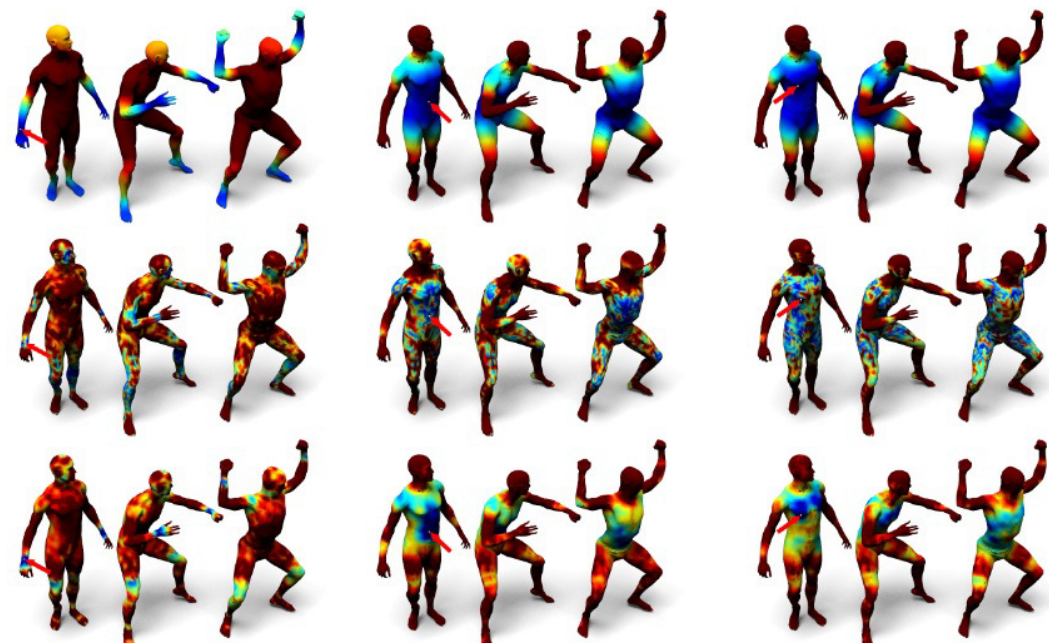
Figure 11. Three kernel-based distance visualized on human models. Visualized distances between the reference point (pointed with red arrows in the first column of each sub-group) and other points on the model. On the left, the reference point is the right writs, in the middle the belly, and on the right the chest. The first row shows the results from the heat kernel, the second row shows the results form the wave kernel, and the third row shows the results of the proposed kernel in [95]. Dark blue shows small distances; red represents large distances. ©2014 IEEE. Reprinted, with permission, from R. Litman, and A. M. Bronstein, Learning Spectral Descriptors for Deformable Shape Correspondence, in IEEE Trans. Pattern Anal. Mach. Intell. , 2014, 36 , 170–180.